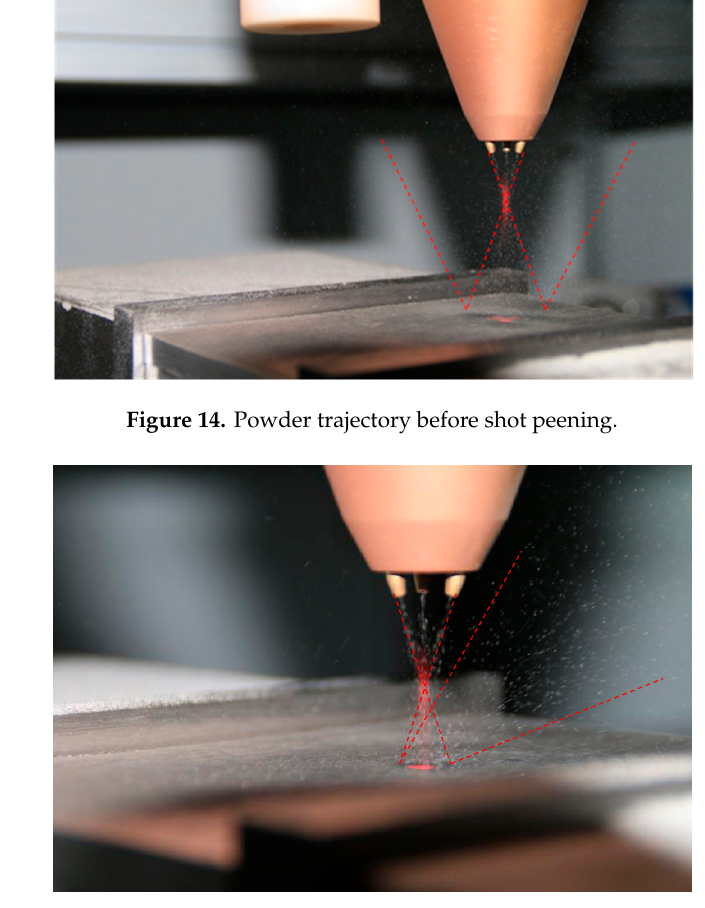
Figure 15. Powder trajectory when shot peening.